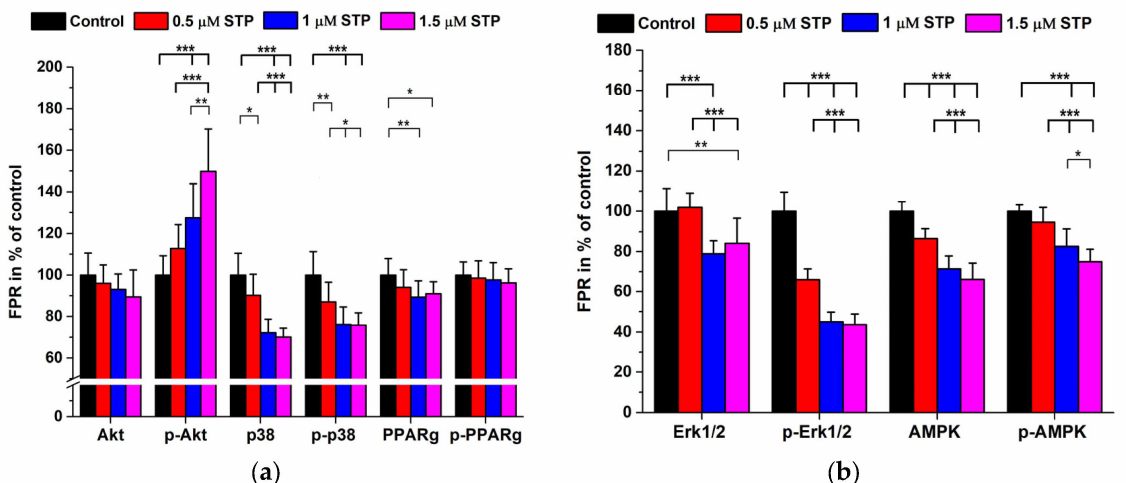
Figure 6. Signal protein and related phosphoprotein expression in STP (0–1.5 µ M) treated HepG2 cells. (N = 6 × 4). ( a , b ): data expressed as FPR in % of the controls. *: p < 0.05, **: p < 0.01, ***: p < 0.001.